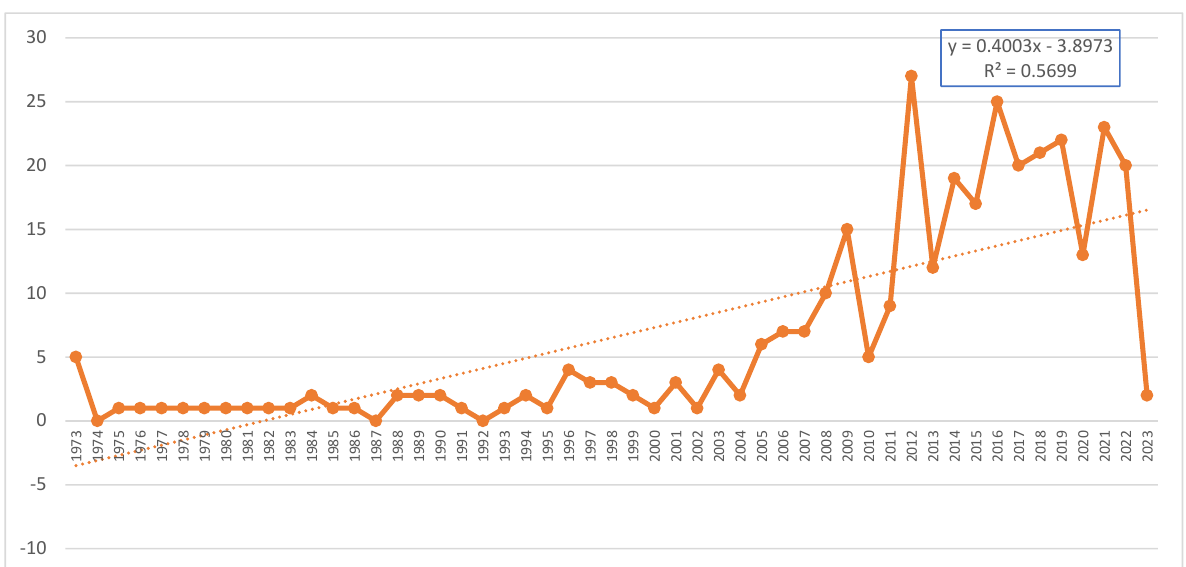
Figure 4. Number of papers per publication year (2000−2021); Source: Authors’ work based on Scopus.